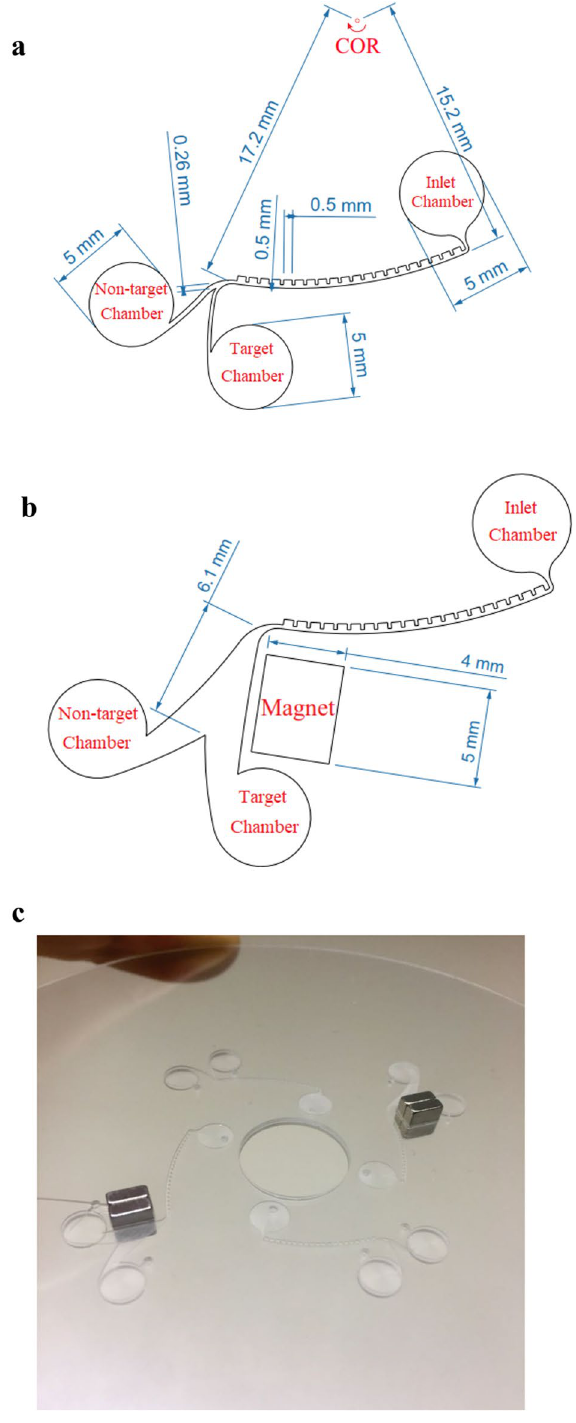
Figure 2. Schematic illustration of the separation device. ( a ) Passive design. ( b ) Hybrid design. ( c ) Device fabricated by CNC micromachining of a plexiglass